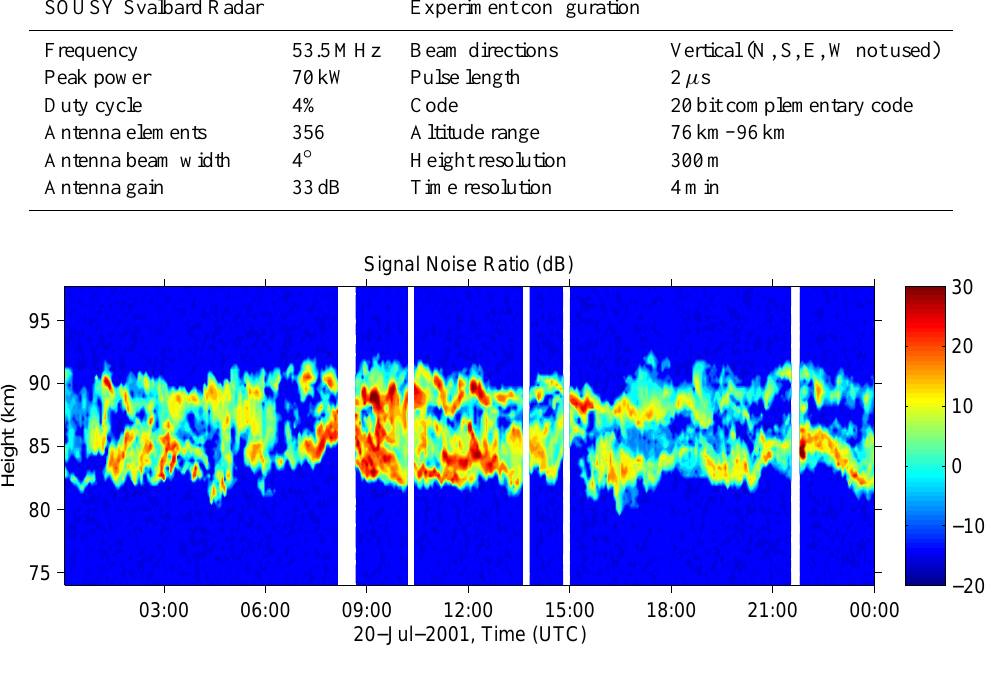
Fig. 1. Image plot of PMSE height-time intensity over Svalbard during a single day. The colours show the signal-to-noise ratio, white gaps mark short interruptions resulting from transmitter inhabits due to local air traffic